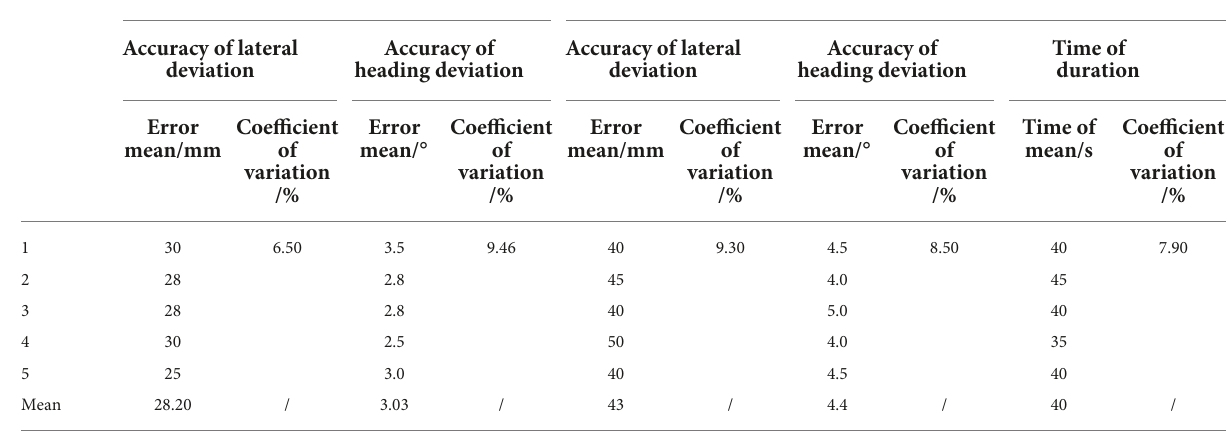
TABLE 6 Test results of detection performance of a normal road edge plane turning to a concave road edge plane.